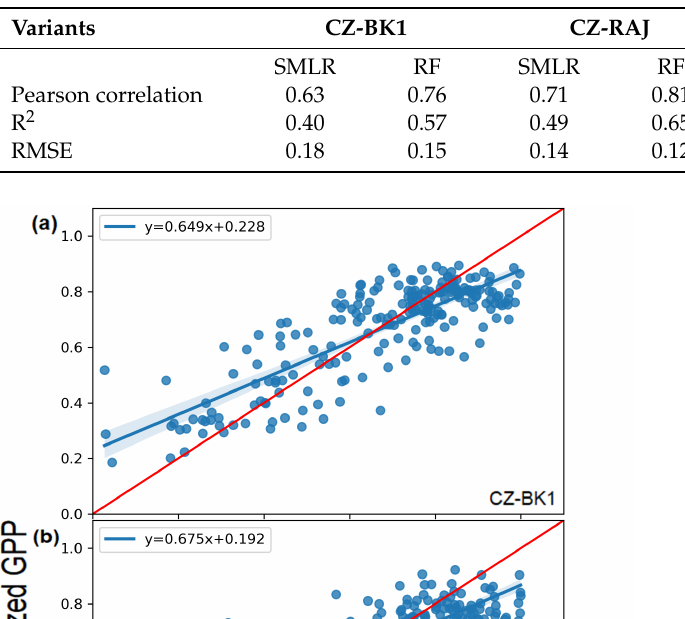
Table 2. Statistical values from the stepwise multiple linear regression model (SMLR) and random forest (RF) analyses showing the accuracy indicators in predicting the Normalized GPP (GPP norm ) values across the wet spruce forest in Bílý K˘rí˘z (CZ-BK1), the dry spruce forest in Rájec (CZ-RAJ) and the beech forest in Štítná (CZ-Stn) for May–September of 2012–2016. The Pearson correlation, R 2 , and root mean square error (RMSE) values have all been shown.